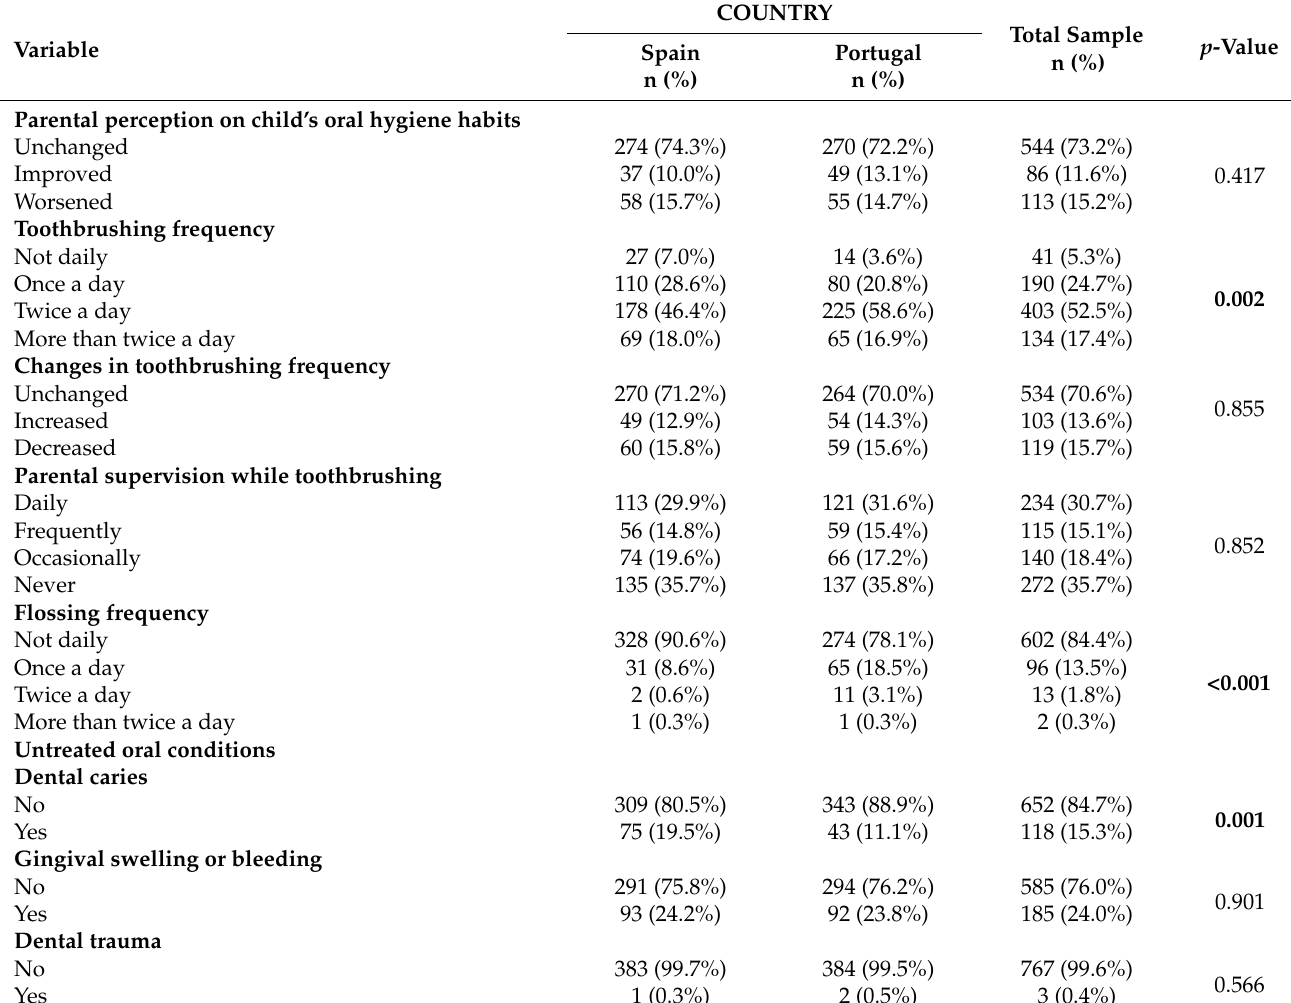
Table 3. Oral health behaviors and status during the lockdown: dental hygiene, untreated oral conditions and dental attendance